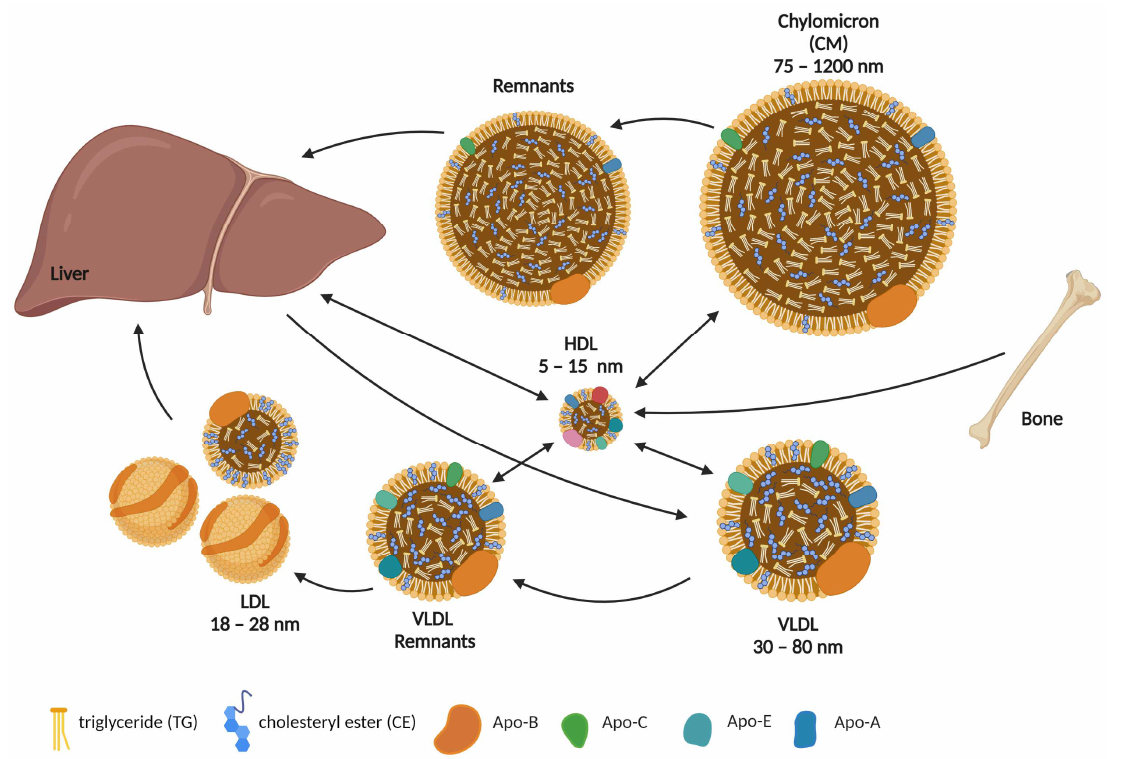
Figure 1. Systemic cholesterol flux. Chylomicrons (CM) are formed in the lymphatic system of the intestinal villi. They package and transport up to half of all triglycerides (TG) and lymph cholesterol. As peripheral lipid uptake progresses, CM lose most of their TG to various cells, whereas the relative content of cholesterol and its esters (CE) increases and their size decreases. CM remnants are taken up by the liver, where CE and TG are eventually hydrolyzed. Very low-density lipoproteins (VLDL) carry TG, phospholipids, cholesterol, and CE from the liver to other tissues. As TG are broken down, the diameter of VLDL decreases and they become low-density lipoproteins (LDL). High-density lipoproteins (HDL) ensure the reverse transport of cholesterol from extrahepatic tissues, such as bone, back to the liver. Important structural components of lipoproteins are the apolipoproteins (Apo), the types of which vary but remain specific to certain types of lipoproteins. This figure was created using Biorender.com (accessed on 24 March 2023).